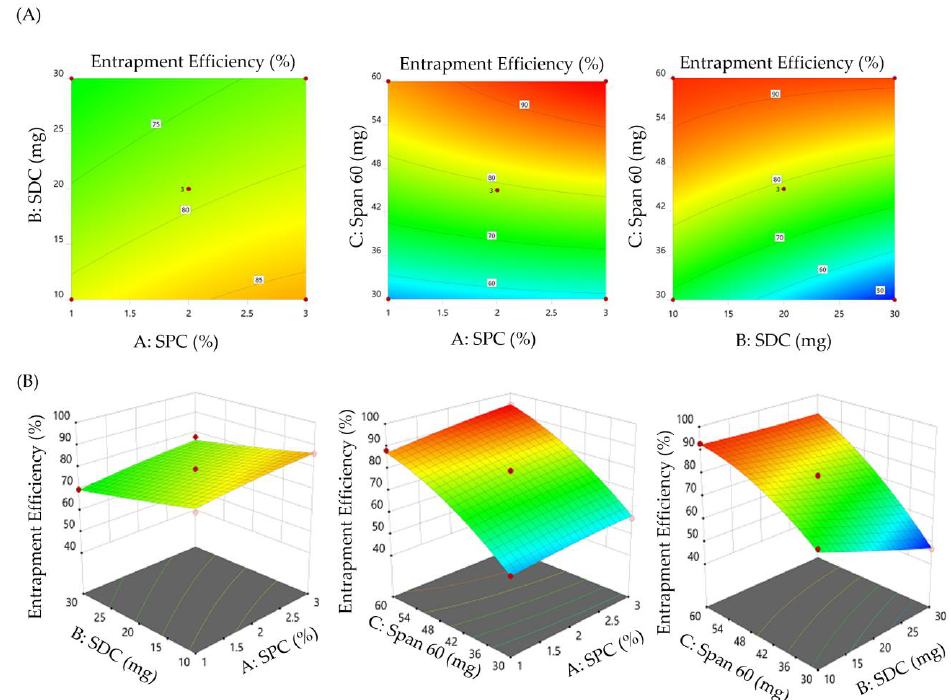
Figure 2. Effect of formulation variables on percentage entrapment efficiency (Y 2 ). ( A ) Contour plots of Y 2 and ( B ) 3D surface plots for Y 2 . Similarly, increasing Span 60 amount from 30 mg to 60 mg resulted in an obvious rise in the entrapment efficiency. At fixed SPC and SDC concentrations, the entrapment